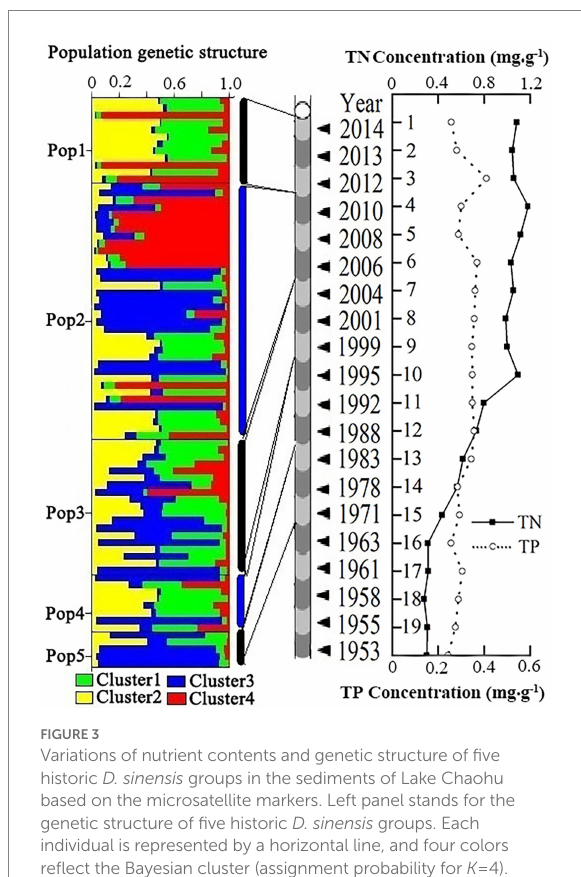
FIGURE 3 Variations of nutrient contents and genetic structure of five historic D. sinensis groups in the sediments of Lake Chaohu based on the microsatellite markers. Left panel stands for the genetic structure of five historic D. sinensis groups. Each individual is represented by a horizontal line, and four colors reflect the Bayesian cluster (assignment probability for K = 4). Center panel stands for the dated sediment core. Right panel stands for TN and TP contents in the sediments of Lake Chaohu. The age of sediments, and TN and TP contents in the sediments cited from Zhang et al.